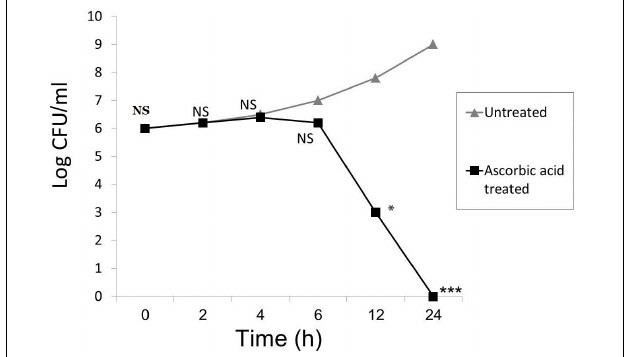
FIGURE 2 | Time-kill kinetics of ascorbic acid. Mean from 3 replicates plotted for all panels; (* means significant, p - value* < 0.05, *** < 0.001, and NS means not significant).